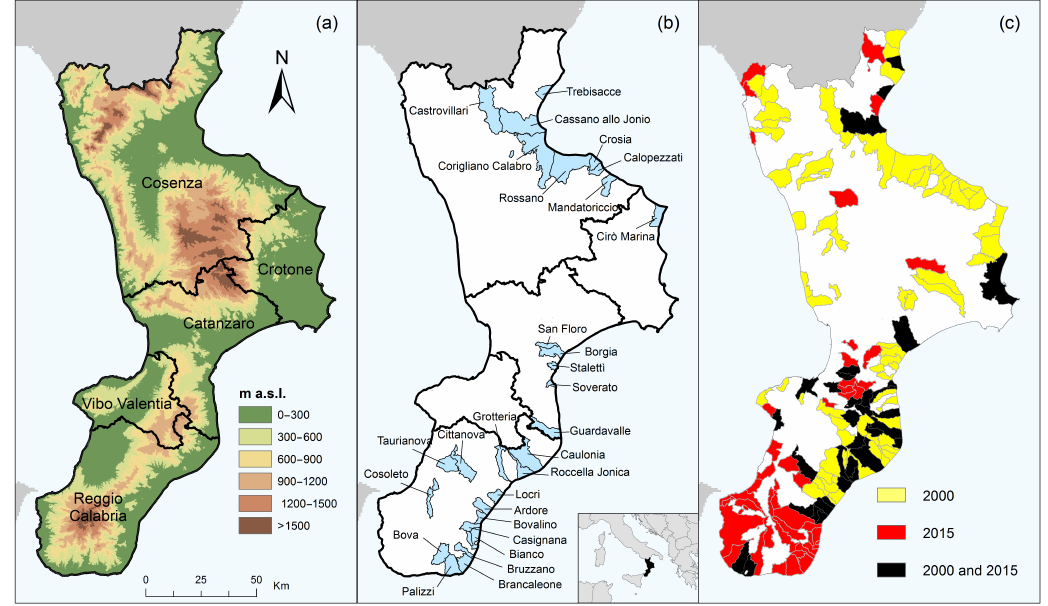
Figure 1. (a) Digital Elevation Model of the study area and regional provinces (Reggio Calabria, Vibo Valentia, Catanzaro, Crotone and Cosenza; (b) Map of the main municipalities damaged during the 2000 and the 2015 DHE and cited in the text; (c) Map of all the munici- palities damaged during the 2000 (yellow) and the 2015 (red) DHE and during both the events